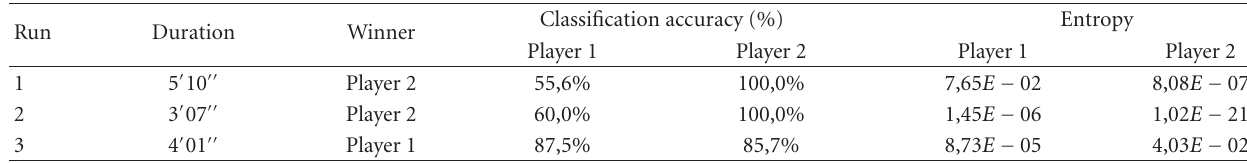
Table 1: Detailed results for the three games in classic mode.